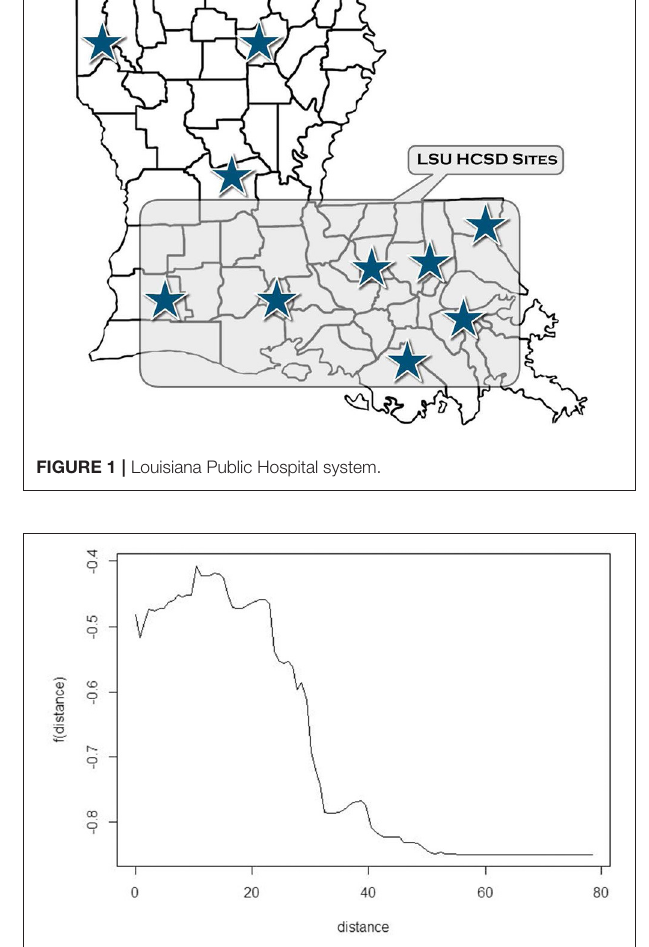
FIGURE 2 | Partial dependence plot to explore the relationship between class attendance and distance to facility. The y-axis is the log odds of attending the smoking cessation